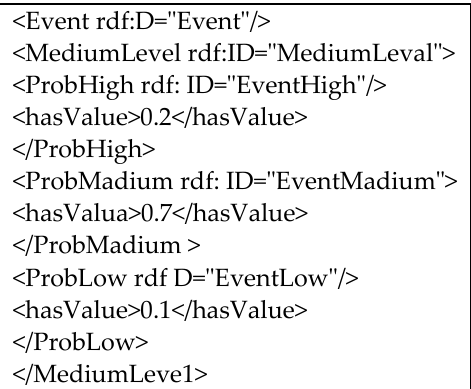
Figure 7. Instances of the medium rank uncertainty event.